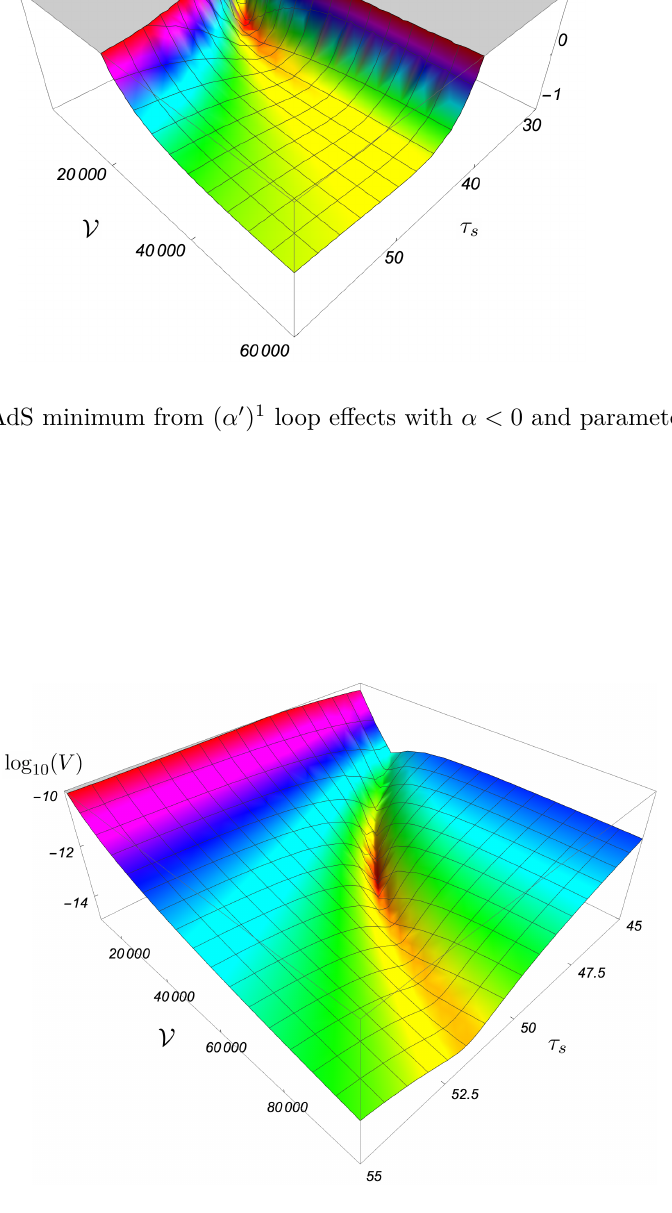
Figure 4 . New dS minimum from ( α 0 ) 1 loop effects with α < 0 and parameter choice